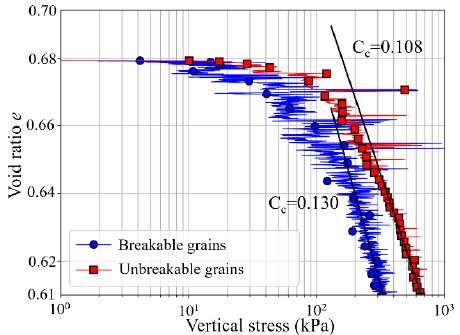
Fig. 4. Oedometric e-log σ curves (median curves) for breakable and unbreakable grain